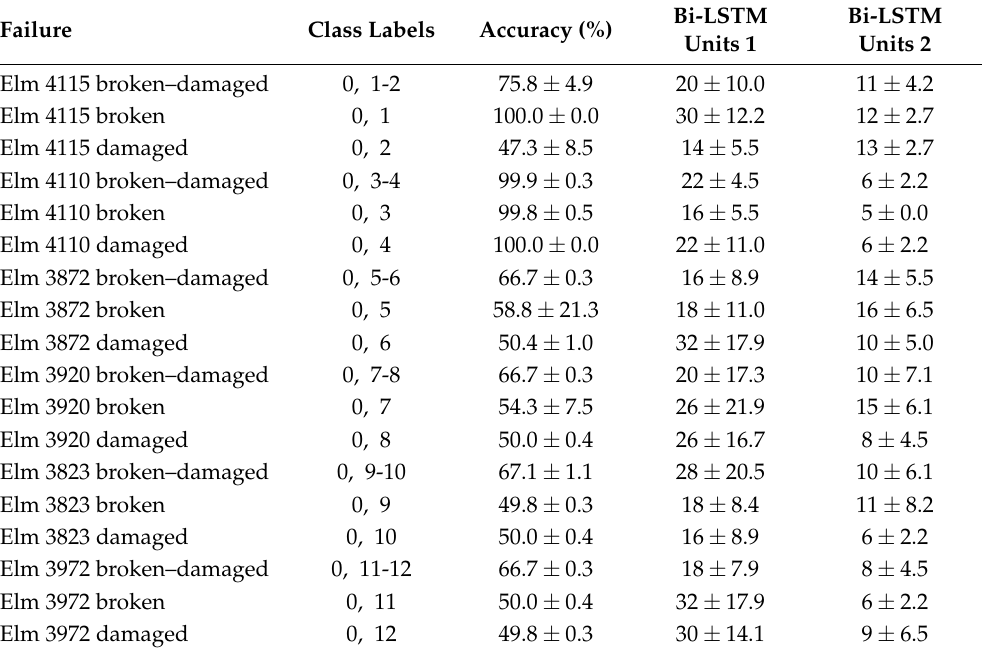
Table 4. Classification Results of the 2-class Structural Health Recognition